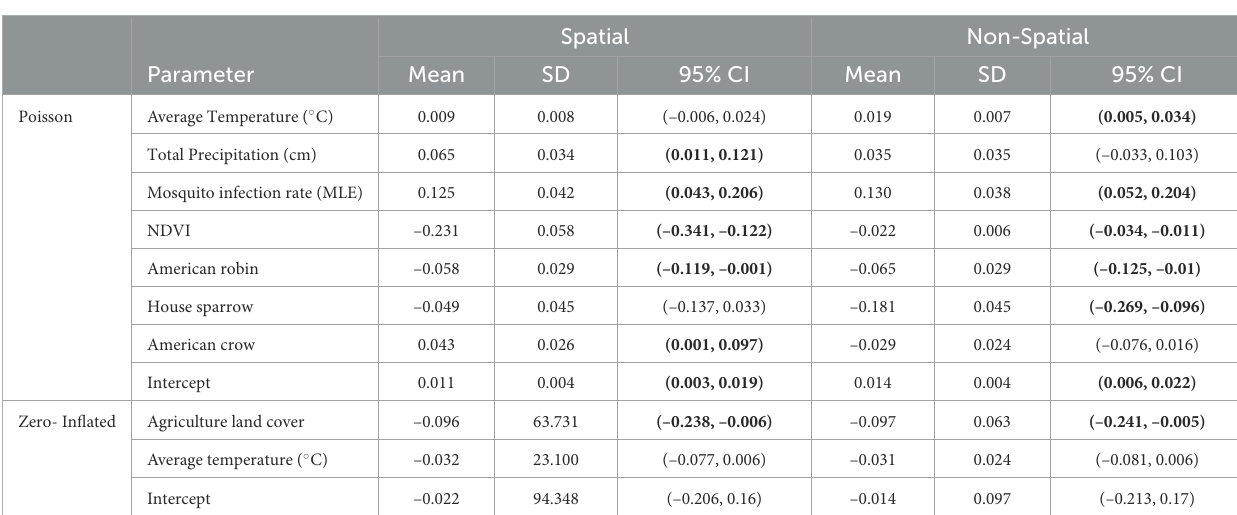
TABLE 1 Posterior results for the spatial and non-spatial